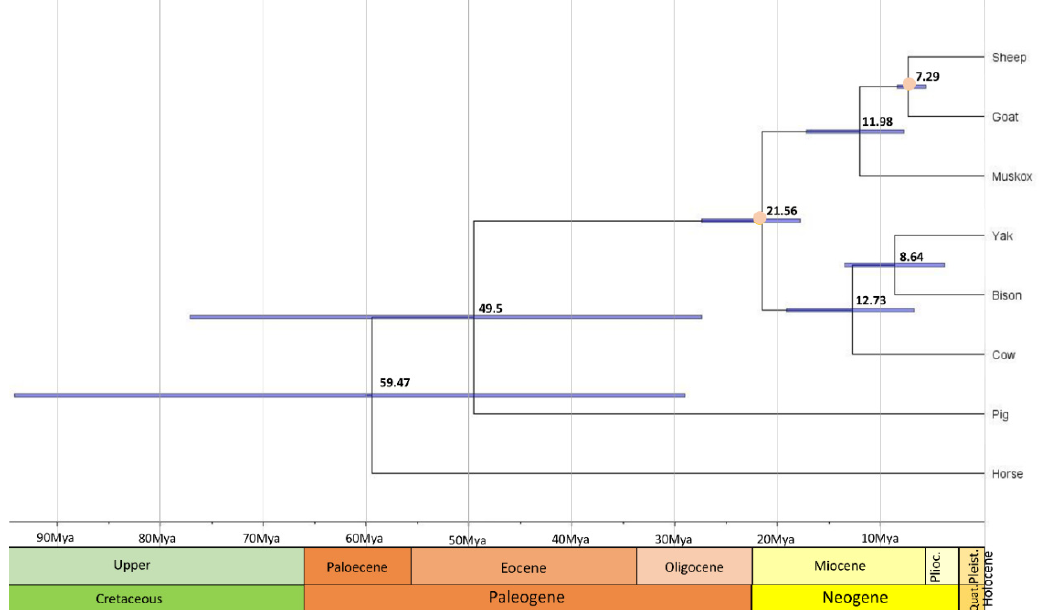
Figure 1. Evolution of gene families among muskoxen and non-Arctic relatives. The phylogenetic tree was constructed using 893 single copy orthologs across all 8 ungulate species. Divergence times are in black, orange dots represent the calibration points, and 95% credible intervals are represented by blue node bars.